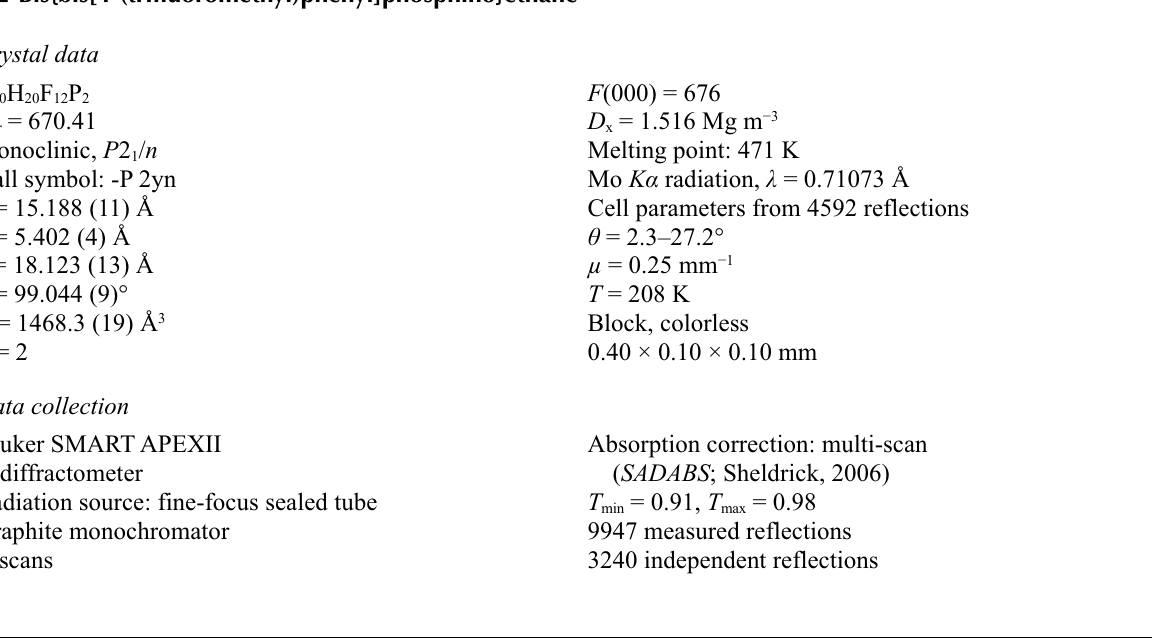
The title compound with displacement ellipsoids drawn at the 50% probability level. Symmetry code: i = - x + 2, - y + 2, - z